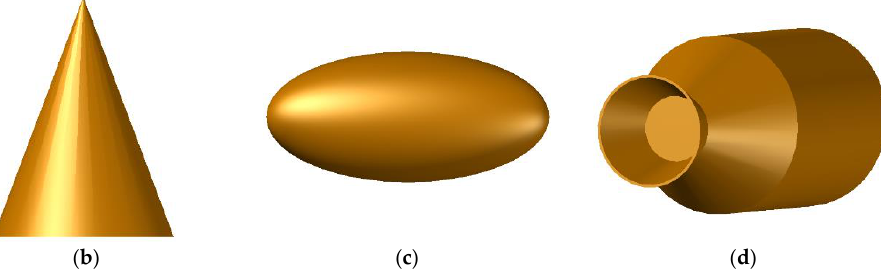
Figure 3. Models of the BTs. ( a ) Warhead; ( b ) Heavy decoy; ( c ) Light decoy; ( d )